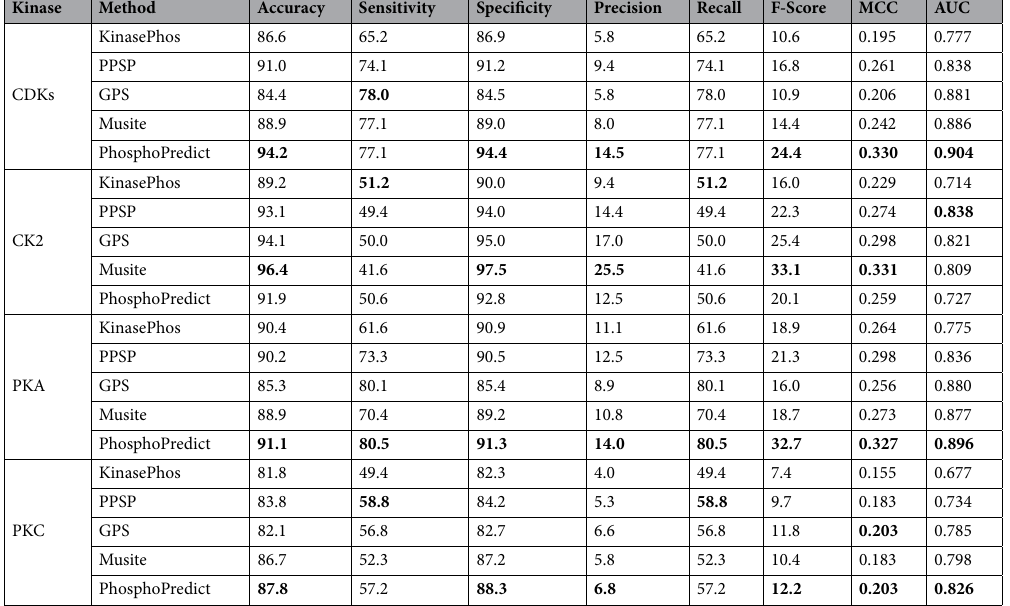
Table 5. Performance comparison of several prediction tools based on the PhosPlus_set. The best results for each kinase and performance measure are highlighted in bold.